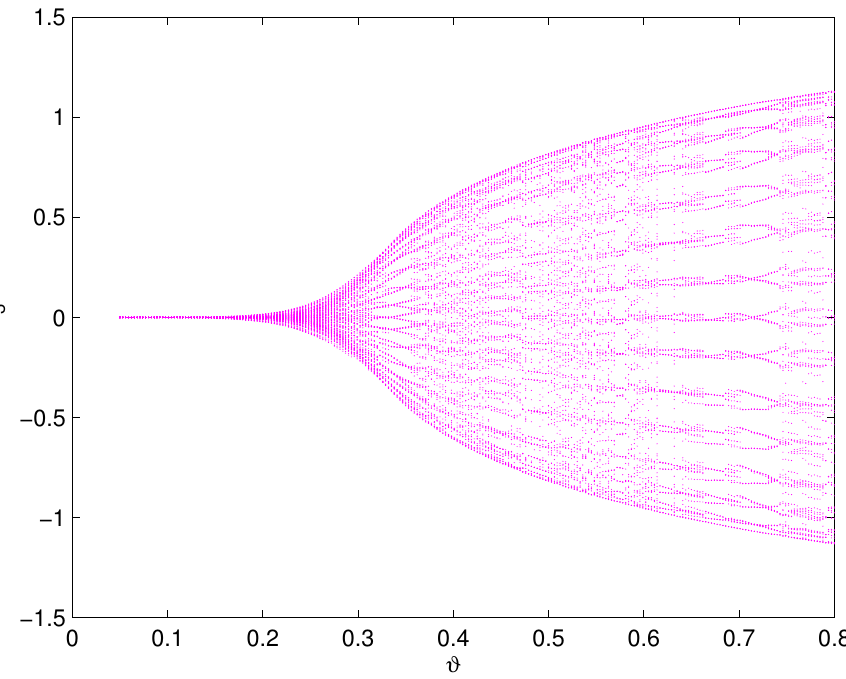
Figure 19. Bifurcation graph of system (73): the time delay ϑ versus the variable w 3 . The bifurcation number is